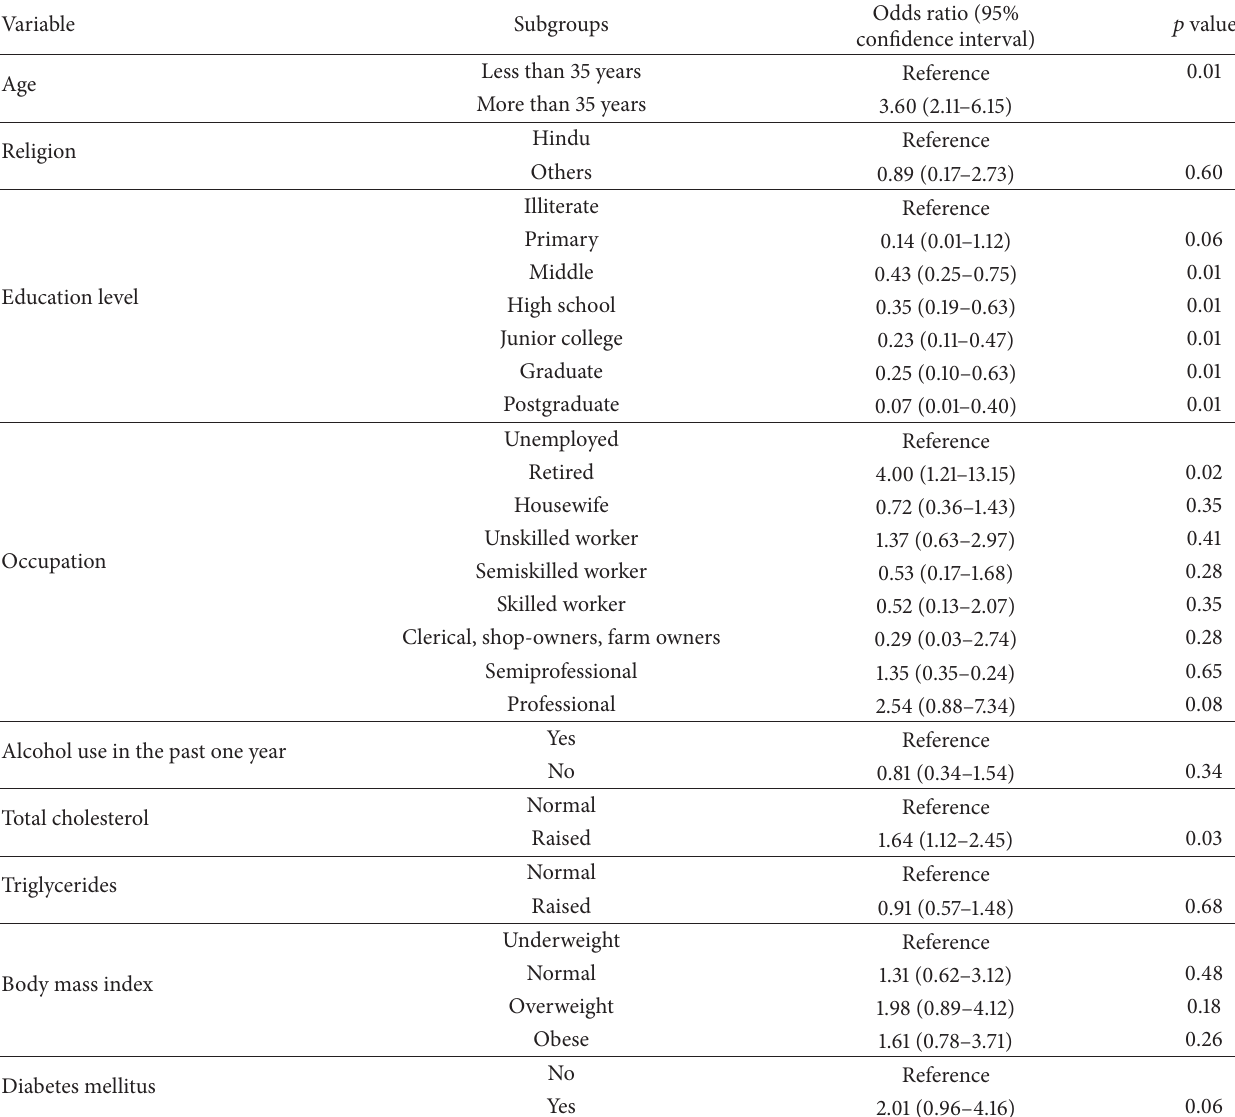
Table 3: Multivariate analysis for risk factors of